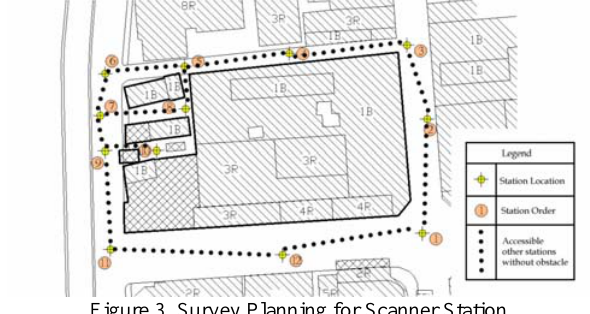
Figure 3. Survey Planning for Scanner Station